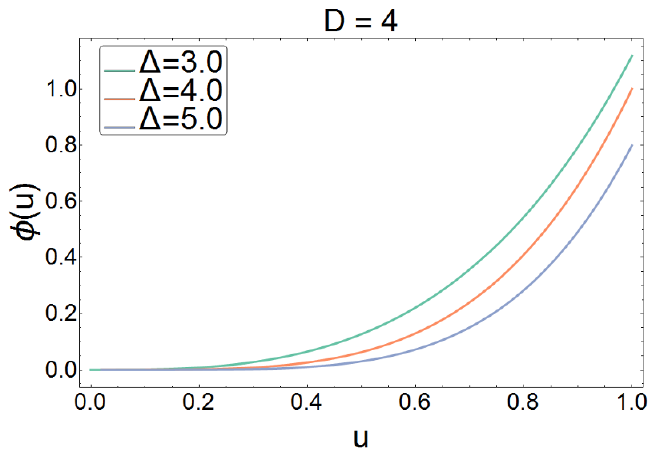
Figure 2 . The scalar (cid:12)eld with D = 4 as a function of u for various scaling dimensions (cid:1) with (cid:8) 1 (cid:12)xed to